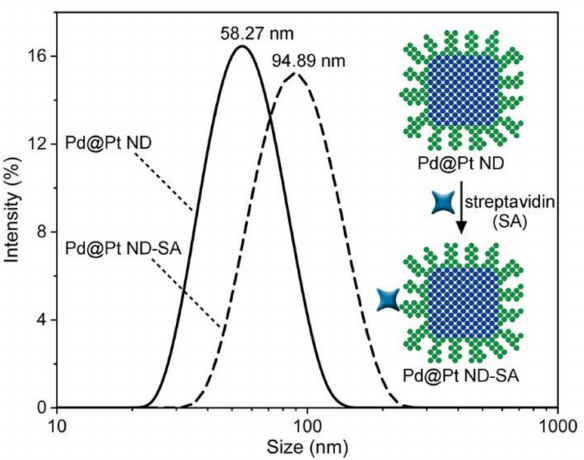
Figure 5. Characterization of Pd@Pt ND-SA conjugates. DLS size distributions of Pd@Pt NDs (solid curve) and Pd@Pt ND-SA conjugates (dashed curve) dispersed in DI